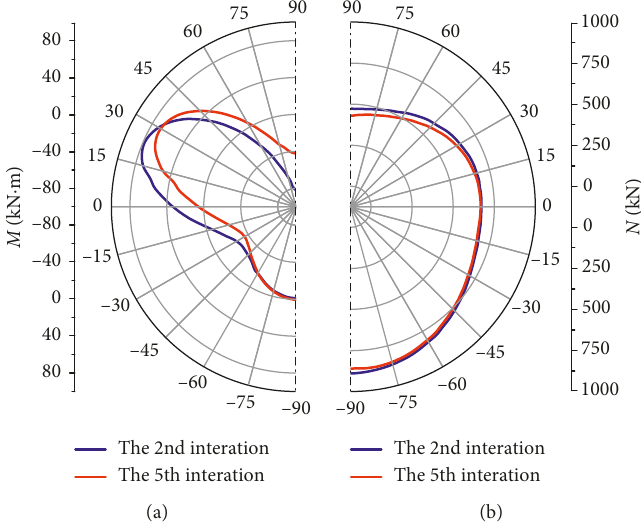
Figure 12: Iteration results of the HEB model. (a) Bending moment. (b) Axial force.